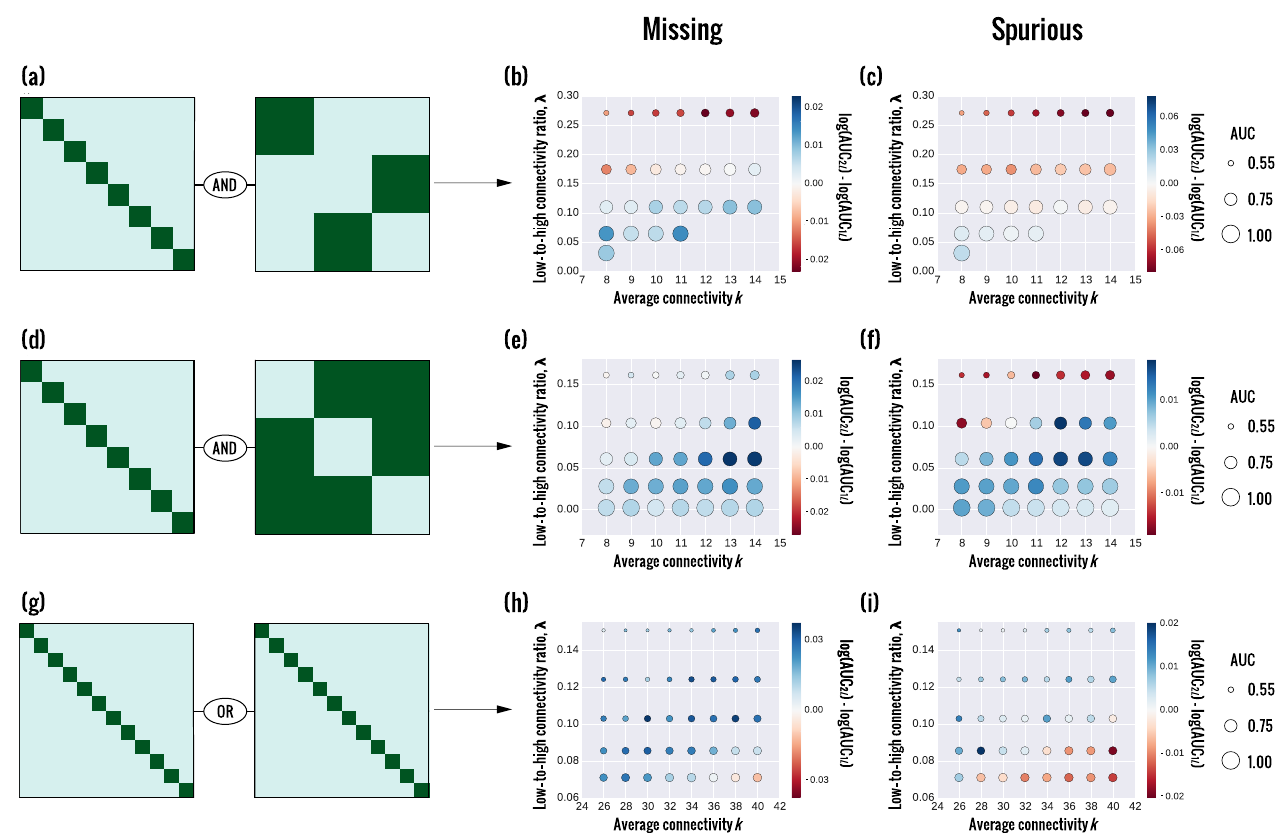
FIG. 3. Performance of missing and spurious link identification on synthetic aggregated two-layer networks. Each row shows results for the different sets of two-layer SBMs illustrated in (a),(d),(g). We consider networks of N ¼ 168 (a),(d) and N ¼ 240 (g) nodes divided into uniform groups in each layer. In the connection probability matrices, dark green represents a high connection probability p h and light green a low connection probability p l . We generate synthetic networks varying two parameters: the low-to-high connectivity ratio λ ¼ p l =p h < 1 and the average connectivity k (see Supplemental Material [48]). To compare the performance of the different approaches at detecting missing links (b),(e),(h), we randomly remove a fraction f ¼ 0 . 25 of the links (false negatives) from the real network and calculate the reliability of each unobserved link. Then we calculate the AUC statistic; that is, we rank the links by decreasing reliability and calculate how often a removed link (false negative) has a higher reliability than a link that does not exist in the original network (true negative). Analogously, to detect spurious links (c),(f),(i), we randomly add a fraction f ¼ 0 . 25 of links (false positives), calculate the reliability of the observed links, and calculate how often an added link (false positive) has a lower reliability than a link that exists in the original network (true positive). For each pair of parameter values, we generate 30 different synthetic networks. We compare the average performance (AUC) at detecting missing links (b),(e),(h) and spurious links (c),(f),(i) of the approximate multilayer SBM approach, AUC 2 L , against that of the single-layer SBM approach, AUC 1 L . The size of the circles represents the AUC 2 L of the multilayer approach. The color of the circles represents the logarithm of the ratio AUC 2 L = AUC 1 L , so that blue circles correspond to instances where the multilayer approach outperforms the single-layer approach, and conversely for red circles. [See Supplemental Material [48] for results for other values of f (fraction of false negatives/false positives) and for synthetic networks generated for different numbers of nodes and/or